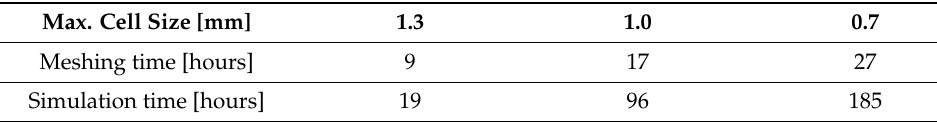
Table 2. Computational time for one complete cold engine cycle.